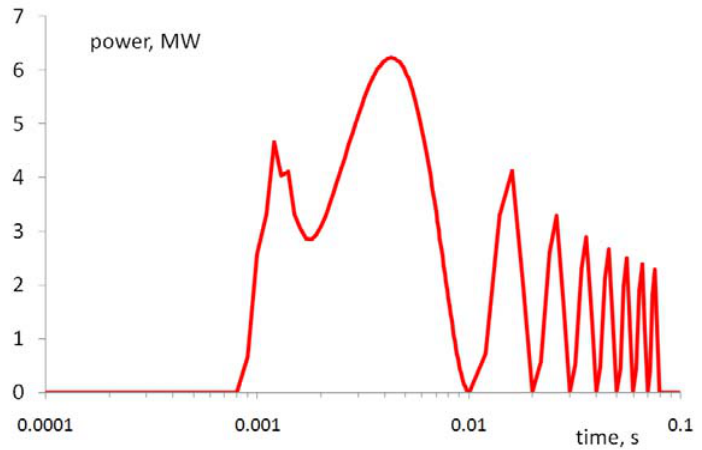
Figure 3. Changes of the power generated in the HTS tape of the limiter during a short-circuit (0 s–0.08 s) for the initial temperature of the limiter before short-circuit = 72 K (first short-circuit test– Figure 4 ).